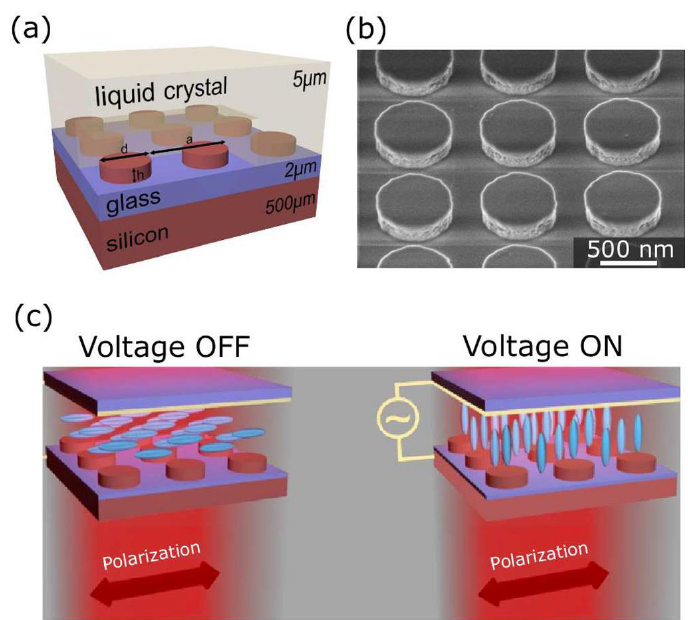
Figure 1. ( a ) Schematic drawing of hybrid structures of nanodisk metasurfaces covered with liquid crystals (LCs). ( b ) Scanning electron microscopy (SEM) image of silicon nanodisks. ( c ) Schematic diagram showing the working mechanism. Reproduced with permission from [95]. Copyright American Institute of Physics,